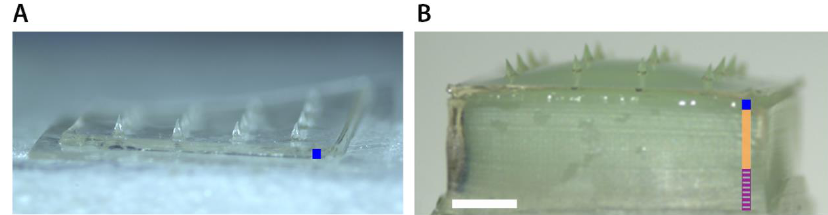
Figure 1. Bright field microscopy image (1.25 × magnification) of a hyaluran dissolving microneedle array (dMNA) without ( A ) and with a bi-layered back-plate ( B ). Dark blue lines in ( A , B ) indicate the thin hyaluronan (HA) layer, the bright orange and purple stripped lines in B indicate silicone and glue layers, respectively. Scale bar (white line) represents 1 mm.